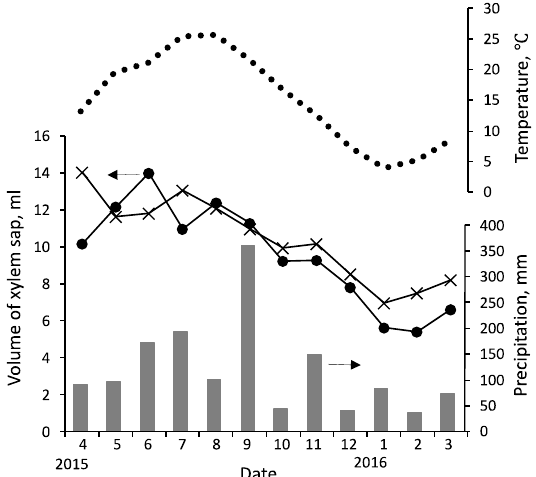
Figure 2. Seasonal variation in the volume of xylem sap collected in water-absorbing resin (Ex- periment 1). The data represent the mean values of three conspecific trees. ●: Q. serrata , ×: C. japon- ica